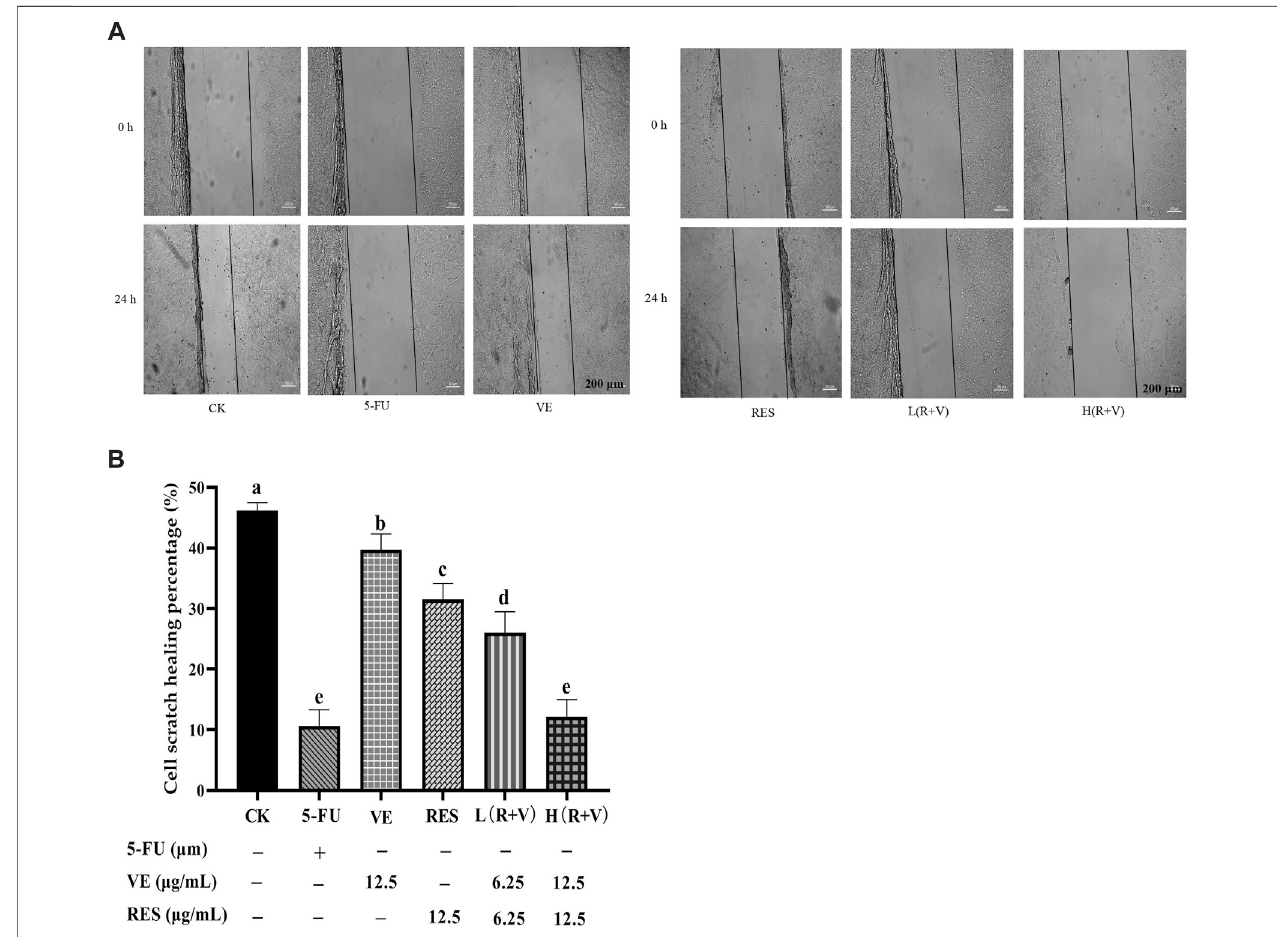
FIGURE2| Theeffectofresveratrol(RES)combinedwithVitaminE(VE)onHCT-8cellmigrationabilityafter24 htreatment. (A) 24-and0 hcomparisonpicturesof different treatments; (B) Migration rate after 24 h. Note: a, b, c, d, e represent the statistical results of different groups. Different letters represent statistically signi fi cant differences ( p <